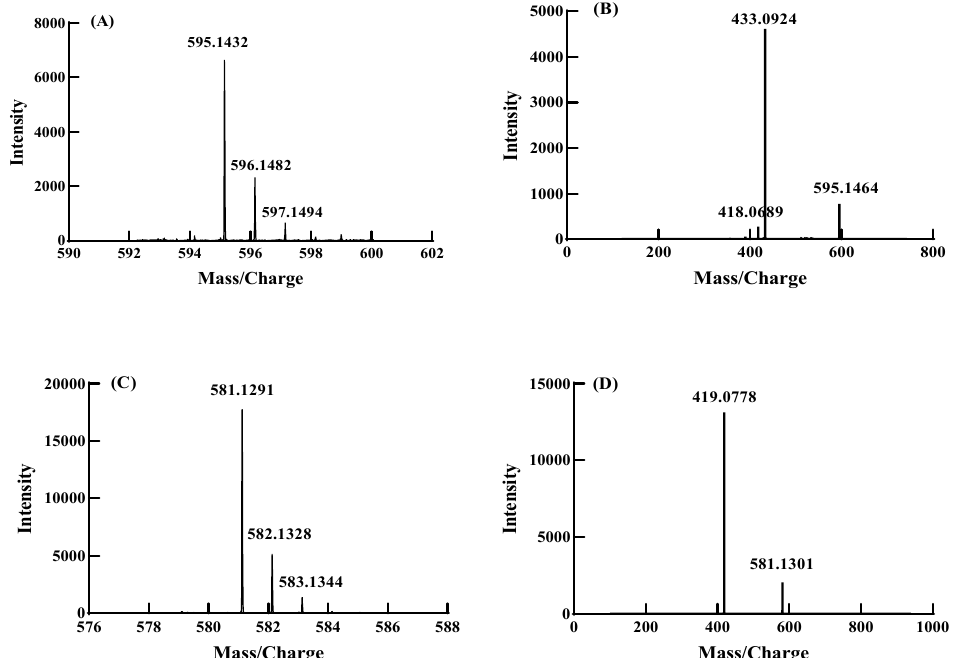
Figure 7. MS and MS/MS chromatograph of co-pigmentation product between ferulic acid/caffeic acid and C3G (( A ): the MS chromatograph of FA–C3G complex; ( B ): the MS/MS chromatograph of FA–C3G complex; ( C ): the MS chromatograph of CA–C3G complex; ( D ): the MS/MS chromatograph of CA–C3G complex).